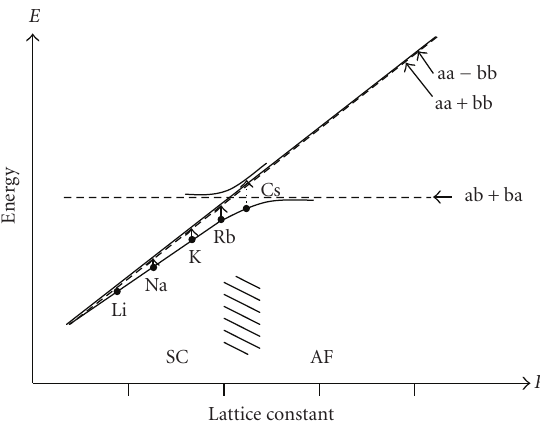
Figure 3: Free energies for the SDW and CDW states as a function of lattices constants in (3). Arrows at the symbol for the element show the superconducting gap. Cs 3 C 60 is in the antiferromagnetic region (AF) where the gap is a